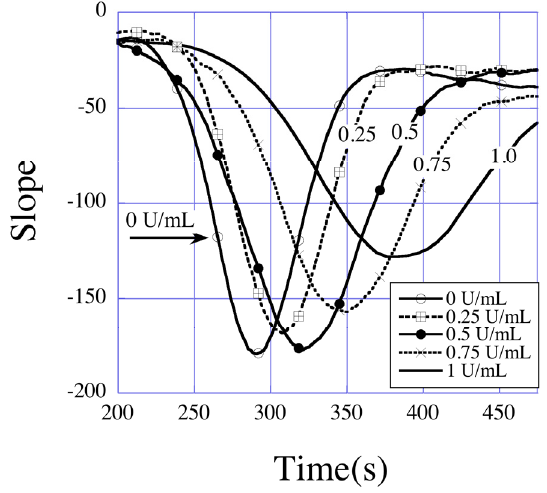
Figure 31. Rate of change of normalized amplitudes (curve slopes in Figure 27) showing the maximum clot rate (minima points) and corresponding clotting times (time of minima). Reprinted with permission from